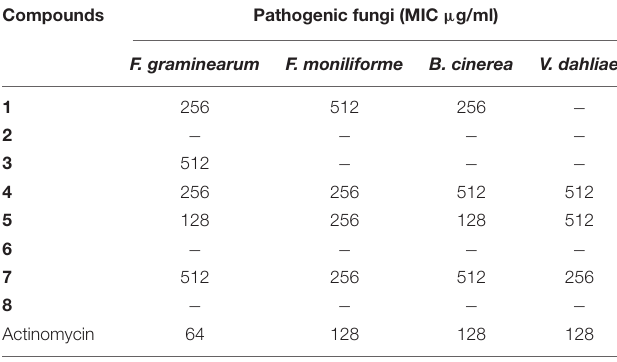
TABLE 4 | Antifungal activity of compounds 1–8 and cycloheximide.